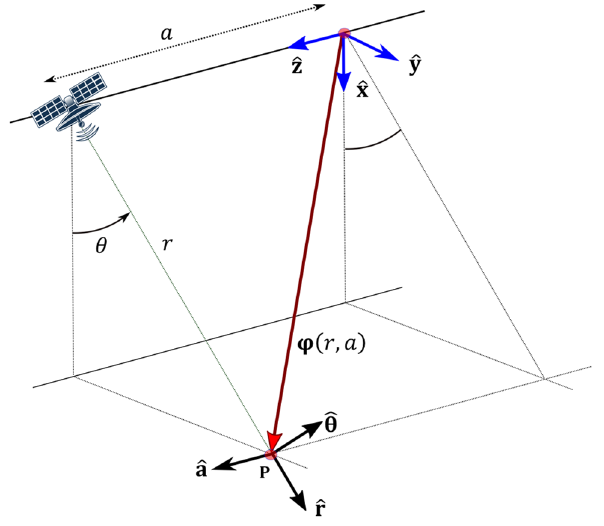
Figure 1. Cylindrical coordinate system.